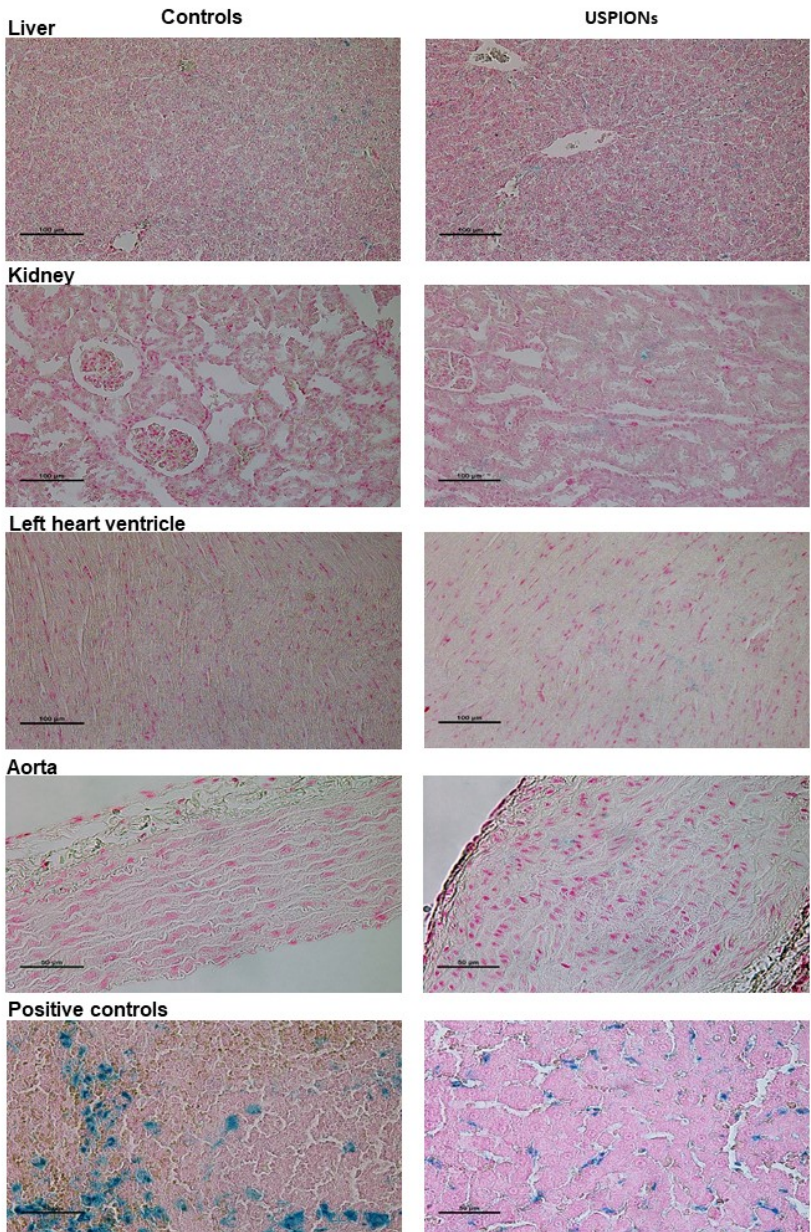
Figure 18. Iron staining in the liver, left heart ventricle, kidneys and aorta of control (left column) and USPION-treated (right column) rats. Staining of iron in the spleen of control rat (bottom left, positive control of biogenic iron) and positive staining of iron in the liver of rats treated with USPIONs at the dose of 20 mg Fe/kg (bottom right, positive control of USPION-originated iron). Prussian blue pigment determines iron. Nuclei are stained in red.